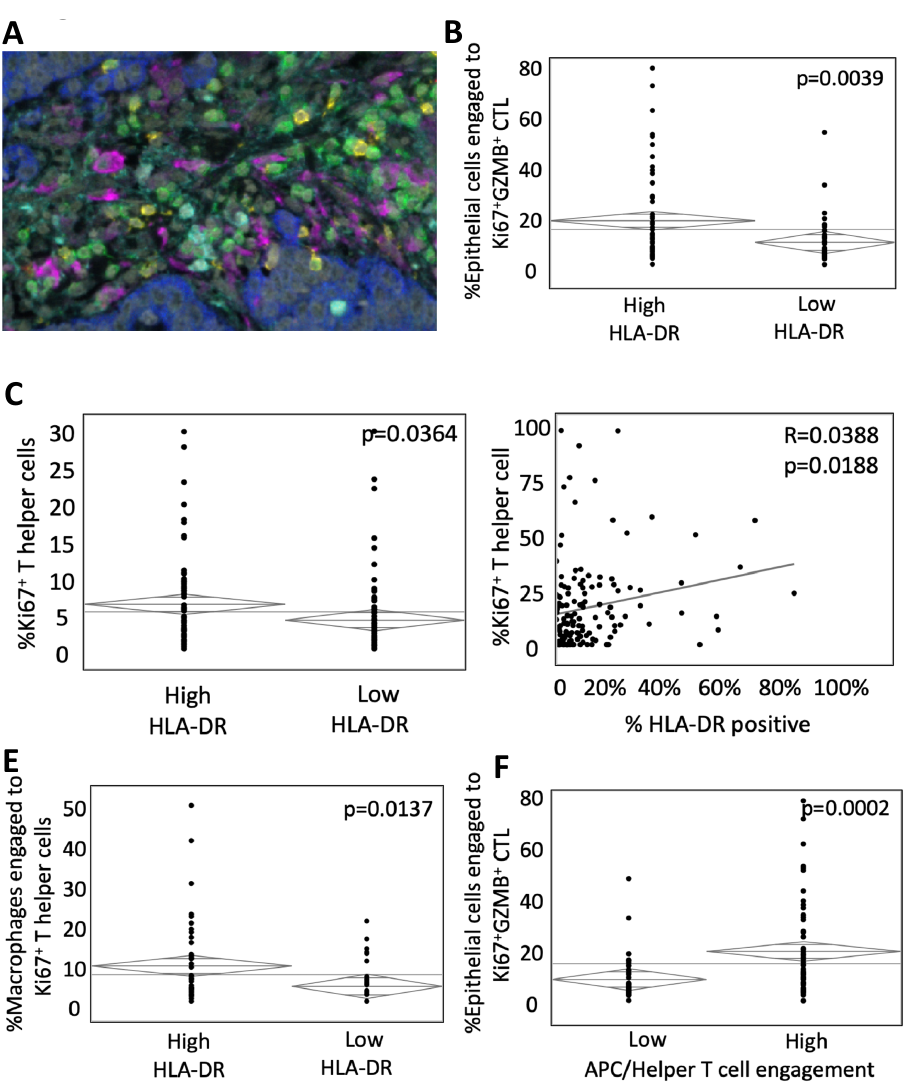
Figure 6. HLA-DR expression influences the proportion and engagement of activated immune cells in the TME. ( A ) Representative multiplex immunohistochemistry image of the metastatic colorectal tumor microenvironment (CD3—green, CD163—magenta, CD8—yellow, pancytokeratin—blue, granzyme B (GZMB)—cyan, and DAPI—white). ( B ) ANOVA analysis of epithelial cells (EC) en- gaged with activated cytotoxic lymphocytes (Ki67 + GZMB + CD3 + CD8 + ) in tumors with high and low HLA-DR expression. ( C ) Relative abundance of activated (Ki67 + ) T helper cells. ( D ) Bivariate analy- sis of activated T helper cells and percent HLA-DR-positive surface area in tumor cores. ( E ) ANOVA analysis of macrophage engagement with activated T helper cells in high and low HLA-DR express- ing tumors. ( F ) ANOVA analysis of EC and activated CTL engagement in tumors with high and low engagement of antigen-presenting and T helper cells. 4. Discussion Metastatic colorectal cancer remains a highly morbid and fatal disease that is rarely cured, despite significant advances in therapy over the past decades. Immune-based ther- apies have been effective only for a small subset of patients with mCRC [25], highlighting the need to better understand the immune microenvironment. Prior studies of the